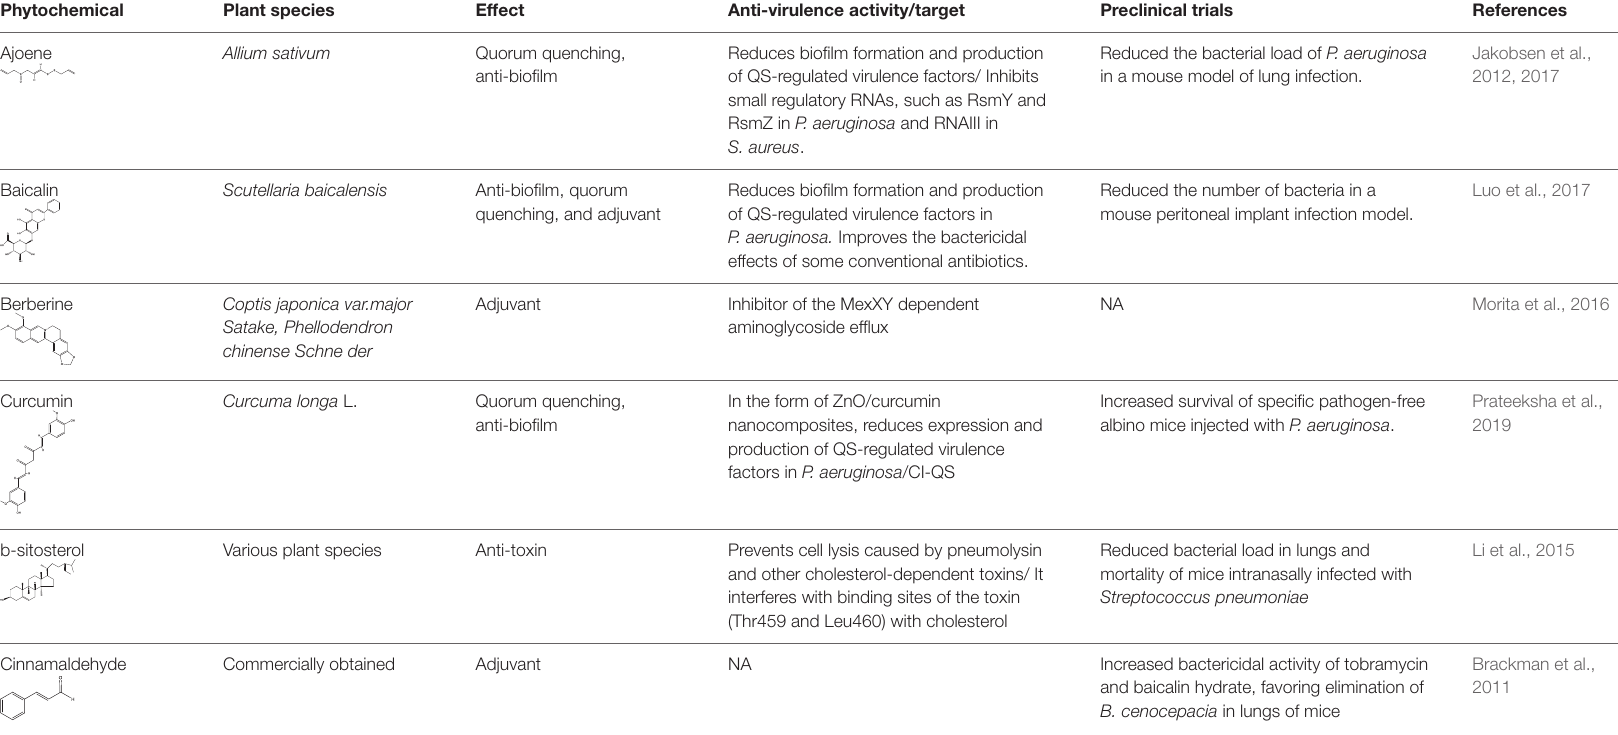
TABLE 1 | Main antibacterial effects of phytochemicals at sub-inhibitory concentrations.